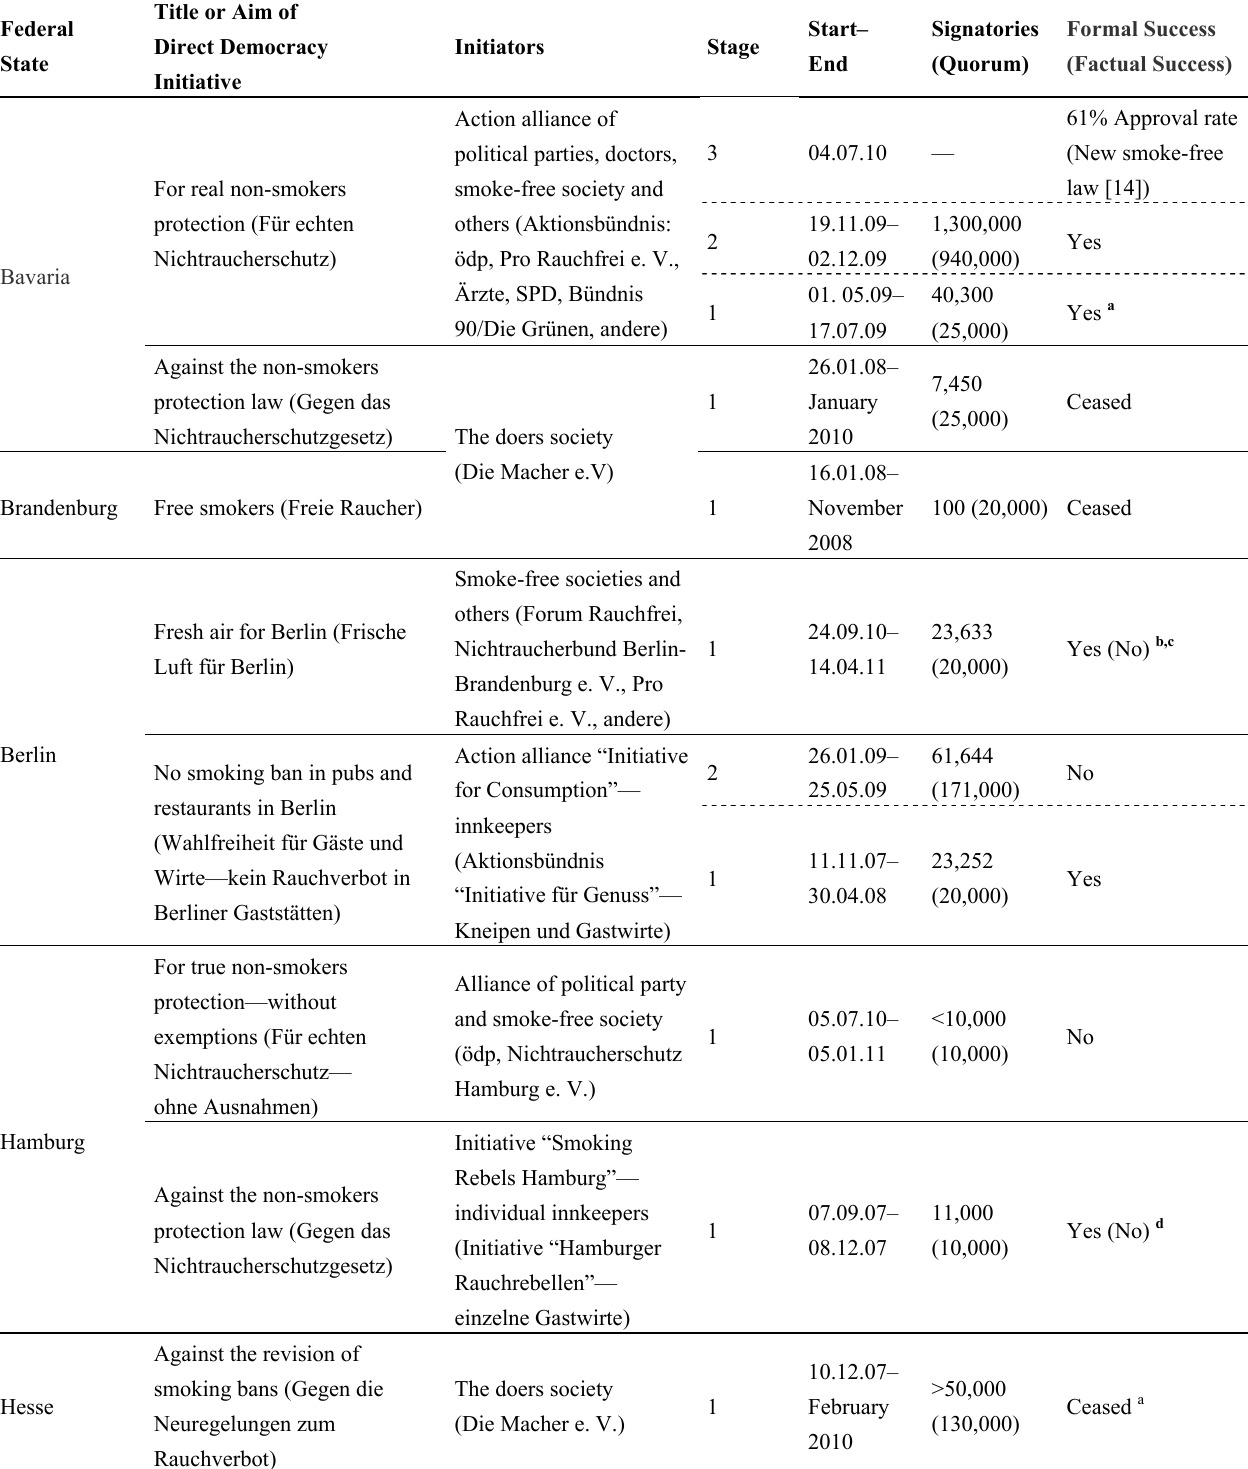
Table 2. Petitions, popular initiatives and referenda on non-smokers protection in